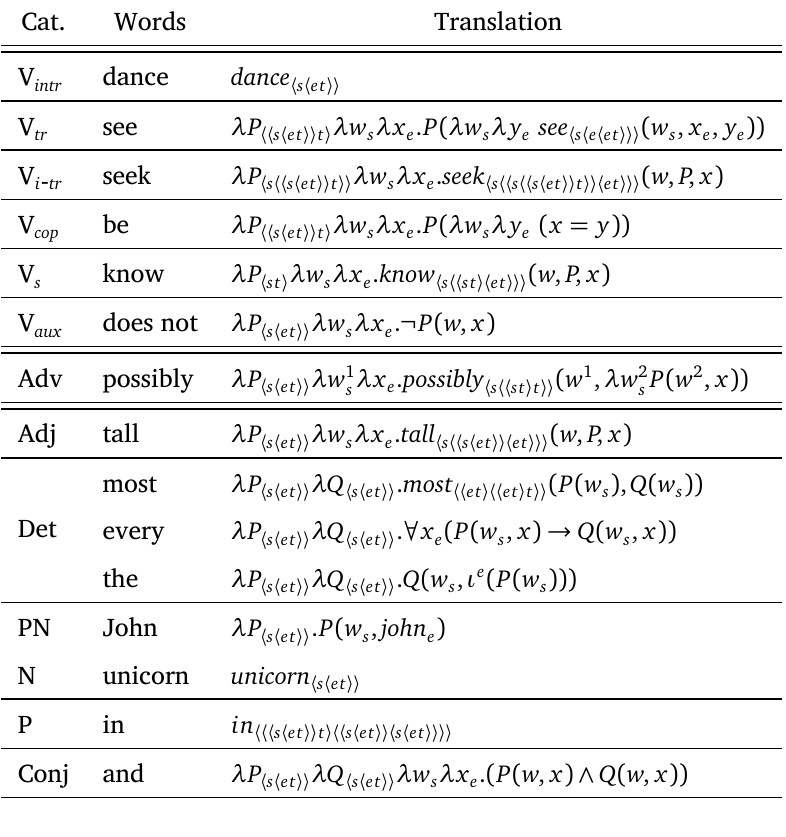
Figure 2: Phrase Structure